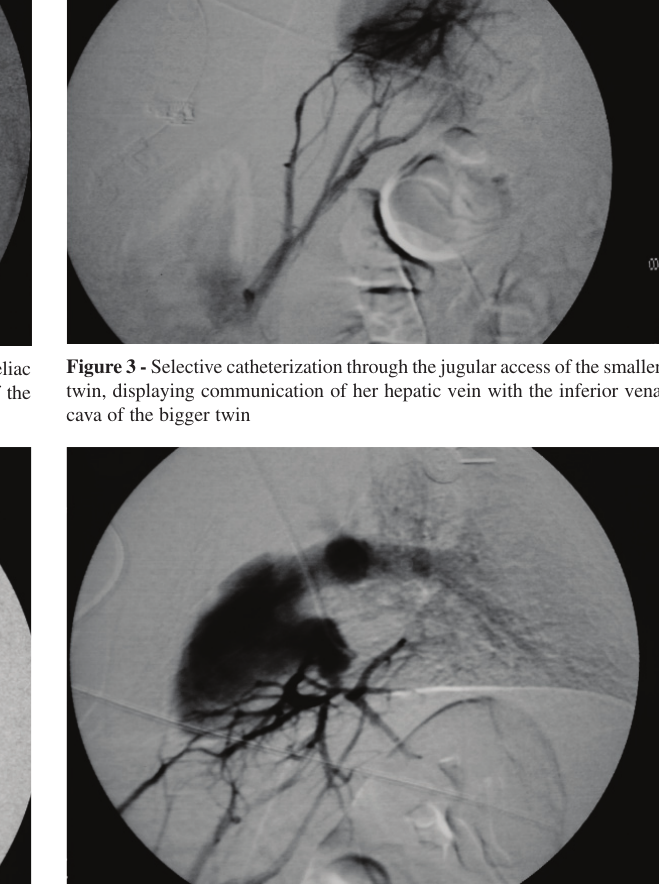
Figure 4 - Hepatic venography of the smaller twin displaying the drainage to her right atrium and posterior opacification of the pulmonary